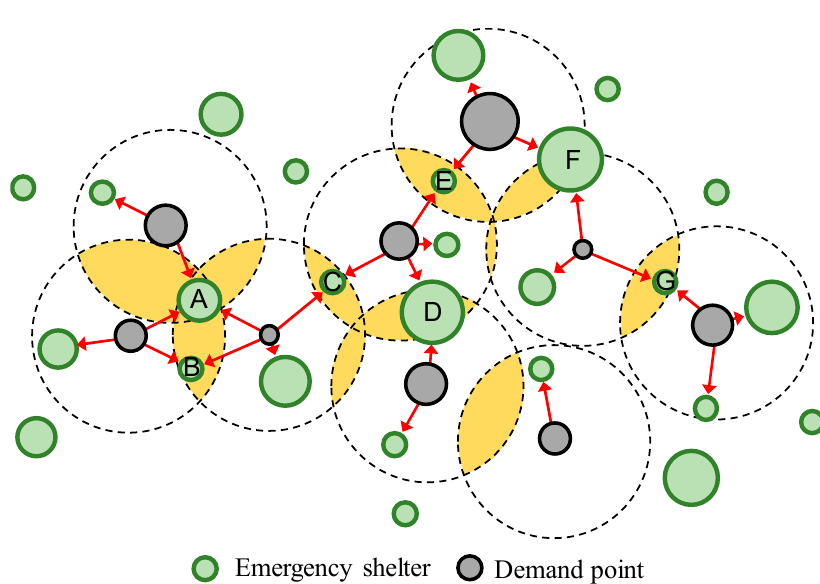
Figure 3. A brief principle map for the evacuation from demand points to surrounding shelters.